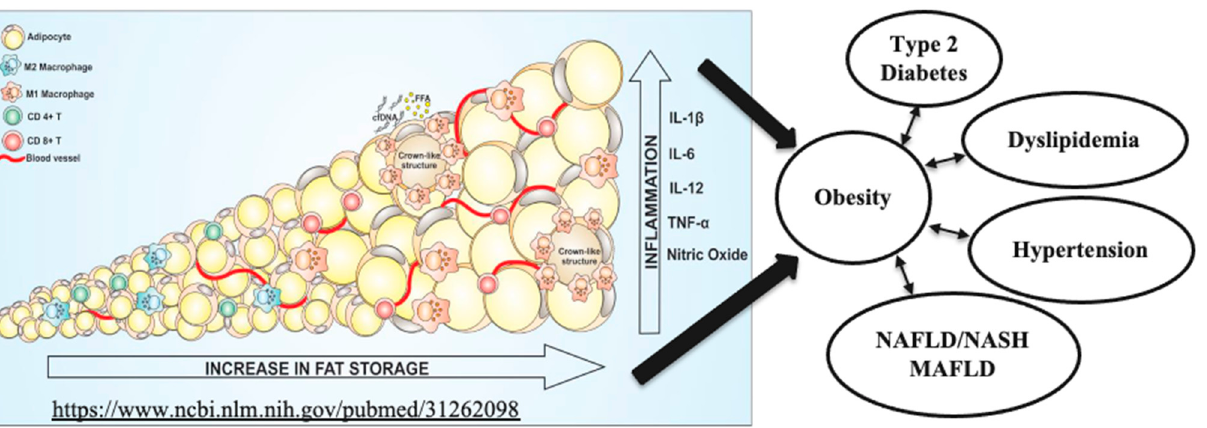
Figure 2. Medical consequences of adipose tissue hypertrophy, hyperplasia, inflammation and necro- sis (adapted from Reference [50], an open-access article distributed under the terms and conditions of the Creative Commons Attribution (CC BY) license (http://creativecommons.org/licenses/by/4.0/ (h tt ps://www.ncbi.nlm.nih.gov/pubmed/31262098 accessed on 20 February 2023).